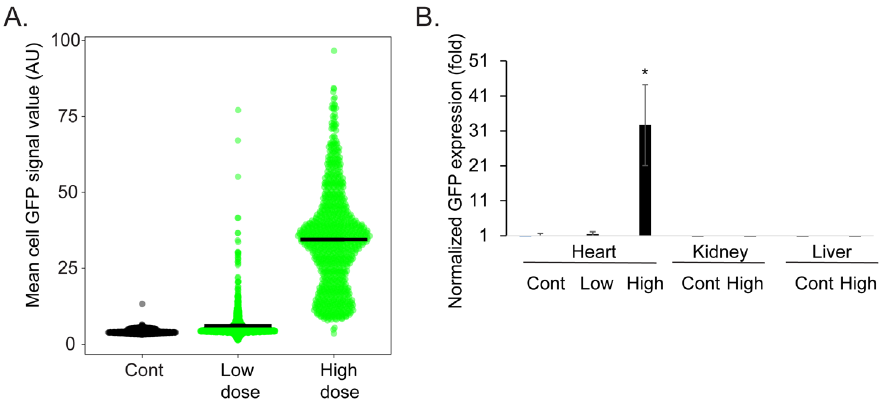
Figure 5. Quantification shows high transduction efficiency. A . A violin scatter plot of mean cardiomyocyte GFP intensity measured from random high power magnification of cardiac sections. Each point represents measurements from one cardiomyocytes in the control, low dose, and high dose AAV9-cTnT-eGFP injected rats, black bars show the mean intensity (N=3 rats, n=~900 cardiomyocytes, in each group). B . Quantitative reverse transcriptase PCR of normalized GFP expression showing very modest expression in the low dose AAV9- cTnT-eGFP rat hearts and high expression in the high dose AAV9-cTnT-eGFP rat hearts. No GFP expression was detectable in the liver or kidney even in the high dose AAV9-cTnT-eGFP rats. N=5 rats. Bars show the average ± standard error. * Student t-test vs. control